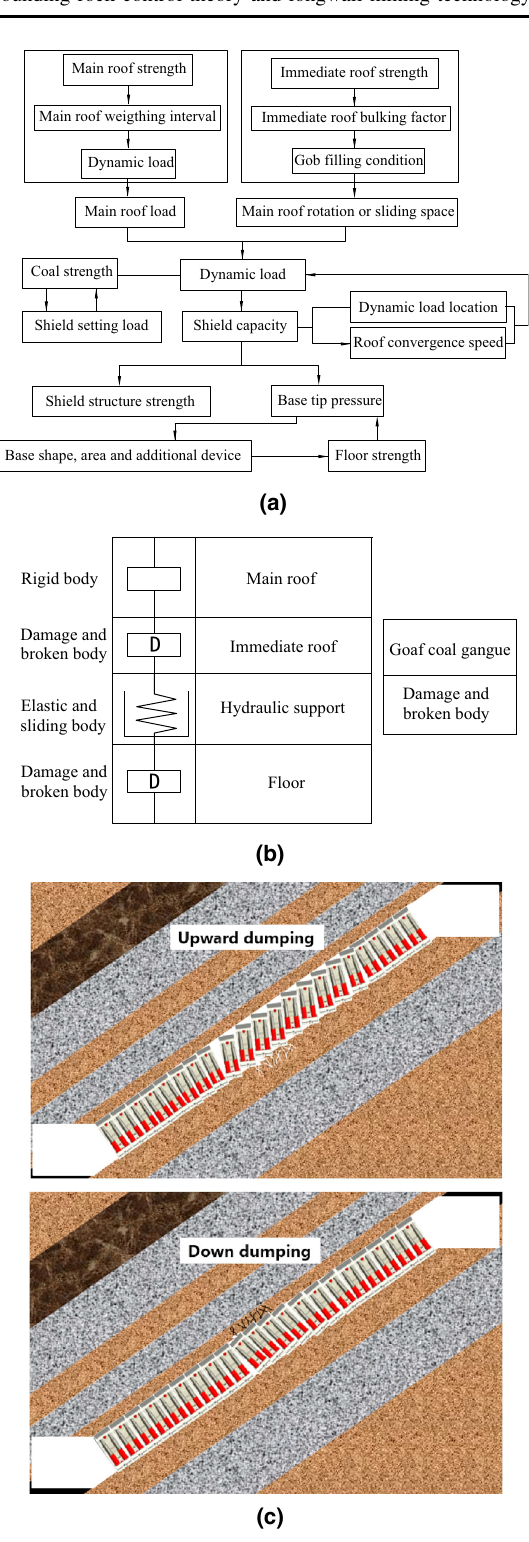
Fig. 1 Coupling relationship between hydraulic support and sur- rounding rock. a Strength coupling relationship, b Stiffness coupling relationship, c Stability coupling